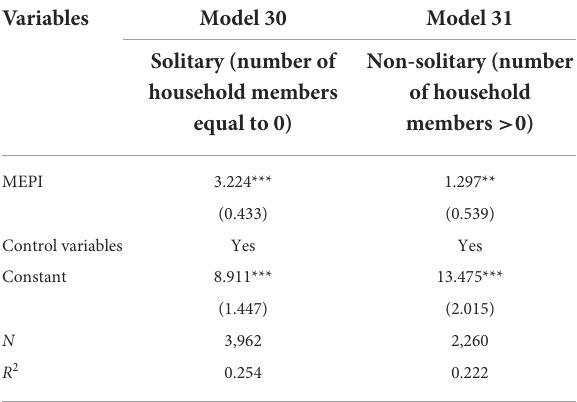
TABLE 9 Estimation results of multivariable linear regression model by solitary